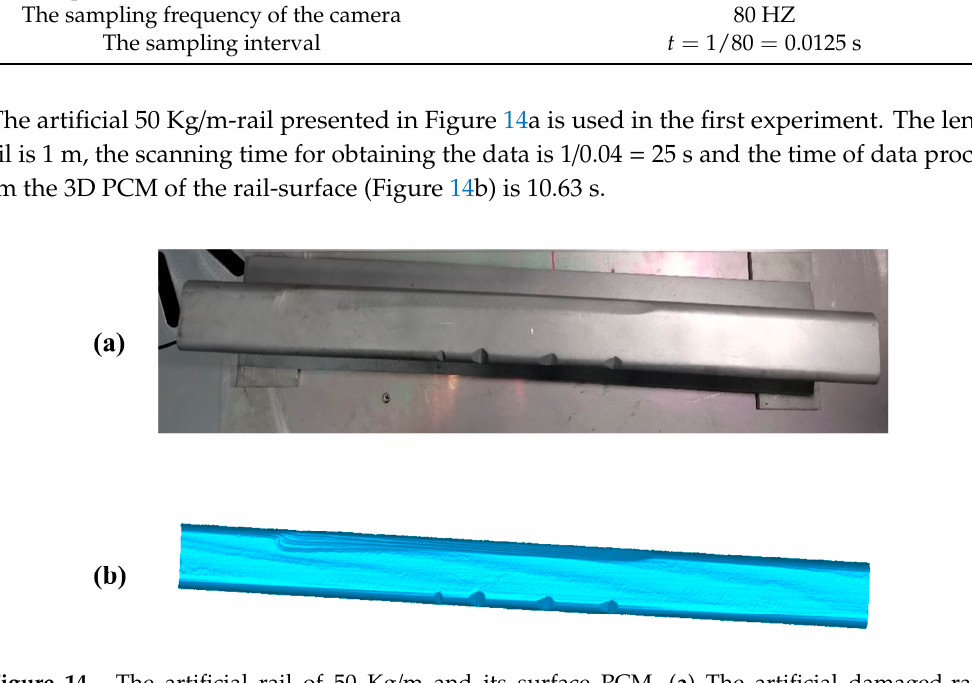
Figure 14. The artificial rail of 50 Kg / m and its surface PCM. ( a ) The artificial damaged-rail; ( b ) The surface PCM of the artificial damaged-rail.